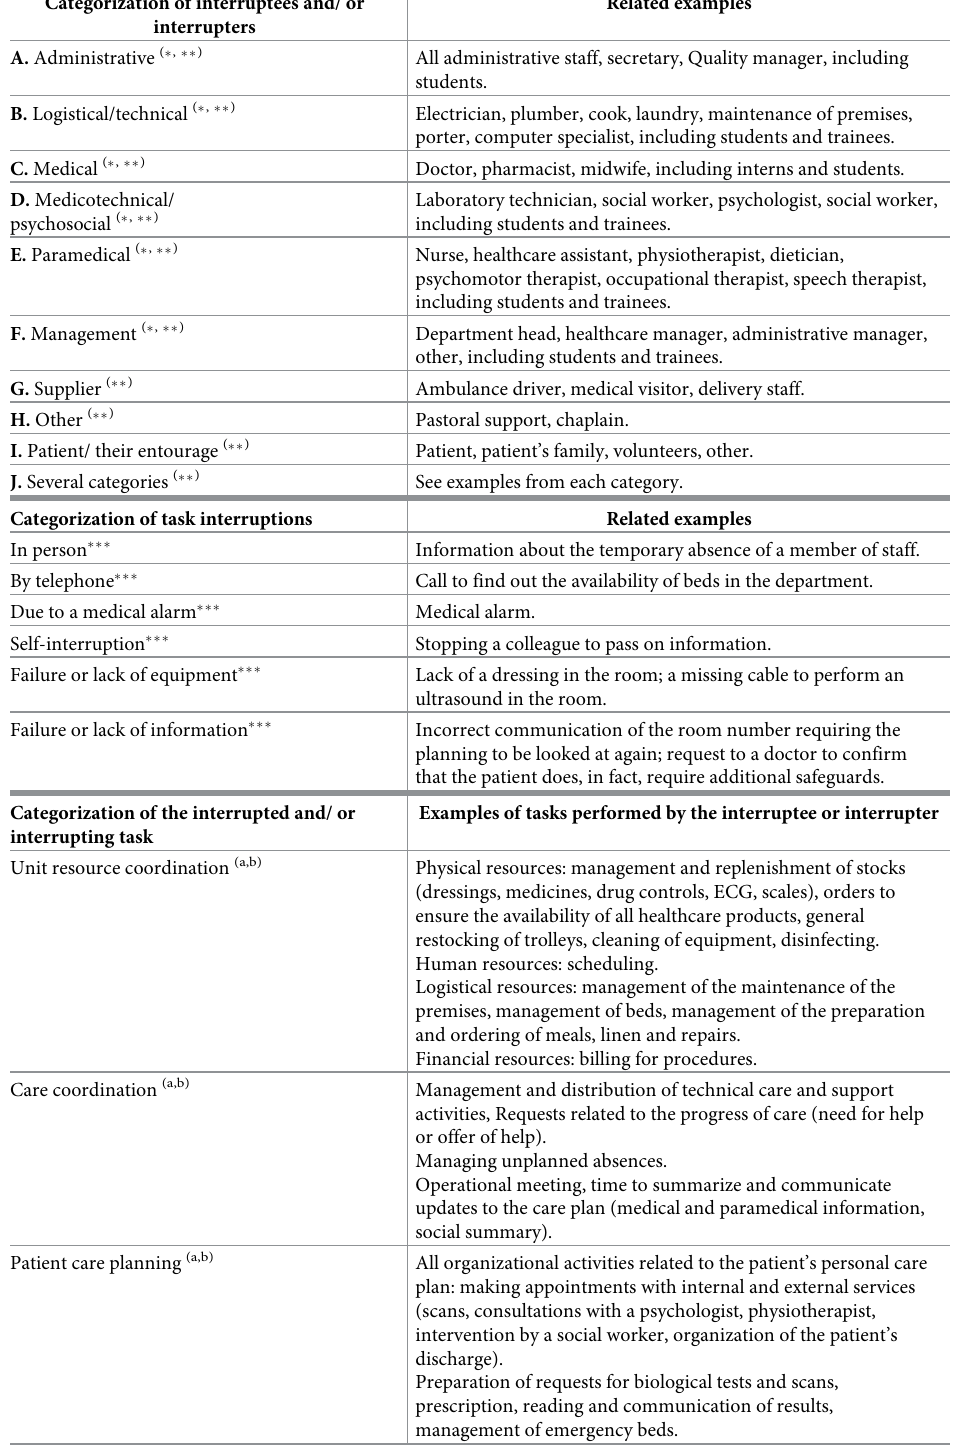
Table 3. Categorization of participating professionals, task interruptions, work functions and stages in the PMP, with